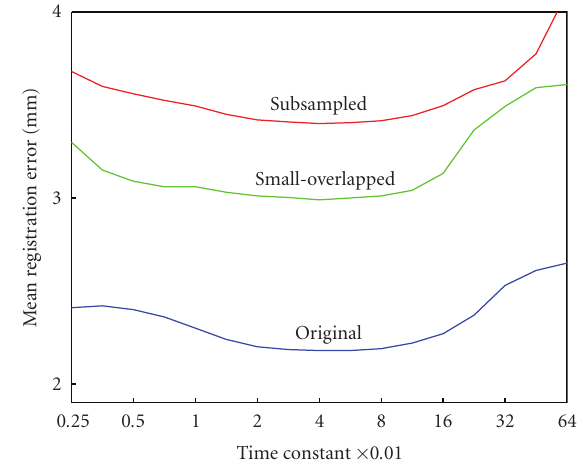
Figure 5: The mean registration error (RE) versus time constant for MRI/PET image pairs (blue), subsampled version (red) and small- overlapped version (green). The registration error is defined as the error distances between the gold standard in the reference image and the centroid of volume of interest (VOI) in the floating image after alignment. The horizontal axis is labeled with intervals of log For each image version, the registration error reaches the minimum near the time constant 0.04 where each is relatively insensitive to the changes of time